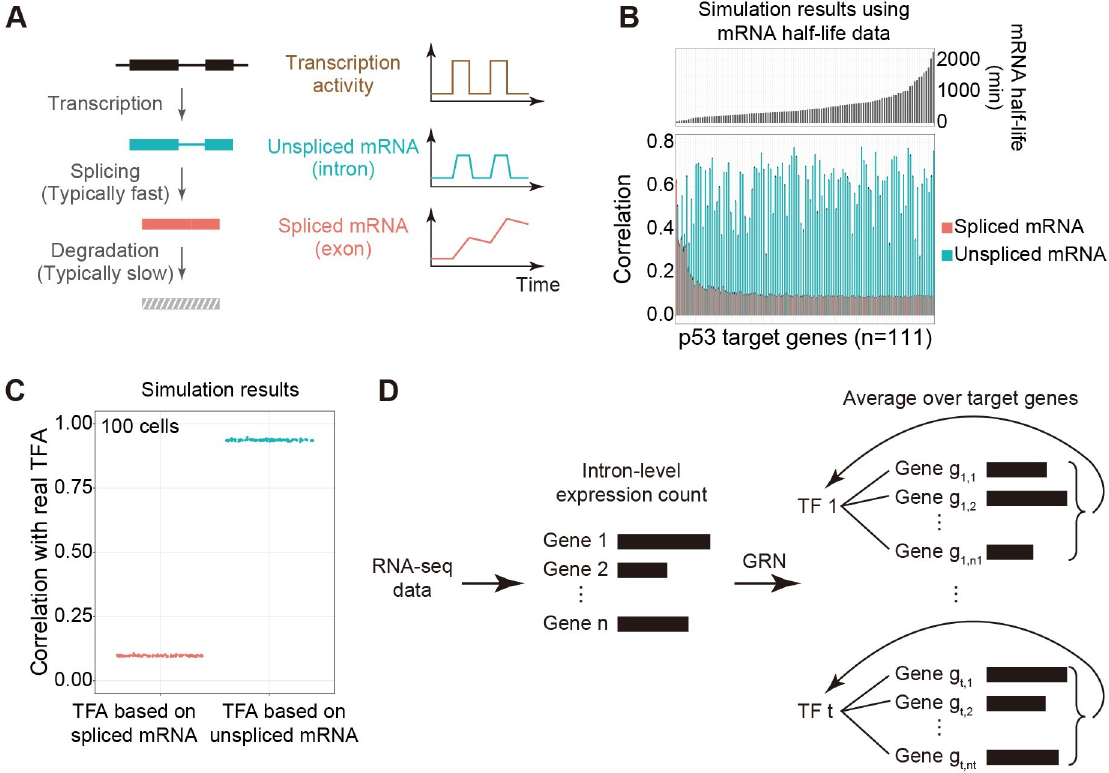
Fig 1. Simulation-based comparison of using spliced and unspliced mRNA levels of target genes for TF activity estimation. (A) Schematics of RNA transcription, splicing, and degradation (left), and the dynamics of unspliced and spliced mRNAs in the presence of dynamically switching transcriptional activity (right). The unspliced mRNA level can generally better follow the activity dynamics compared to the spliced mRNA level (right). (B) Pearson correlations between simulated p53 activity dynamics and simulated unspliced or spliced mRNA levels of target genes (bottom) of different mRNA half-lives (top). Correlations were calculated using stochastically simulated single- cell trajectories as in S1A Fig . Unspliced, but not spliced, mRNA levels show consistently high correlations with p53 activity irrespective of mRNA half-life. Error bars indicate standard errors of 100 simulated cells and n indicates the number of p53 target genes. (C) Correlations between input p53 activities in the simulation and p53 activities estimated using simulated spliced or unspliced mRNA levels. Estimated p53 activities were calculated by averaging the mRNA levels of target genes in the p53 regulon (as in B ). TFA: Transcription factor activity. (D) A pipeline for the estimation of instantaneous TF activity using intron-level information in the RNA-seq data and curated TF regulon information. Normalized intron read counts of target genes in the regulon are averaged as the estimate of intron-based TF activity. As a comparison, TF activity has been conventionally estimated using exon-level